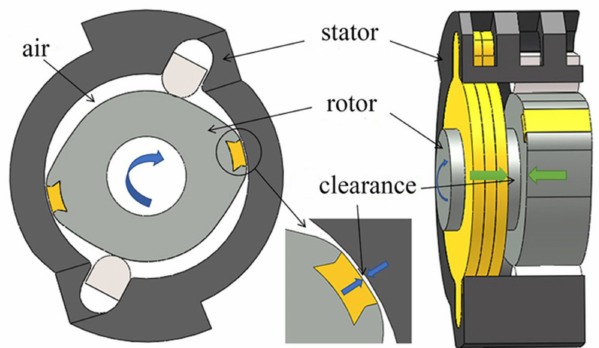
Figure 1. Schematic diagram of the designed pneumatic downhole motor with copper-steel